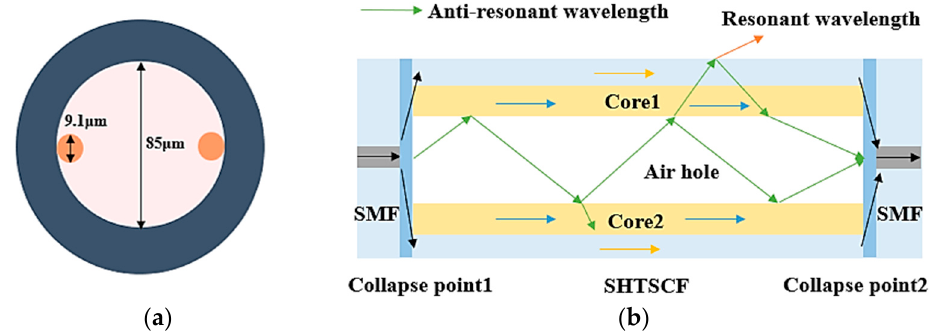
Figure 2. ( a ) The aperture size of the SHTSCF; ( b ) Guiding mechanism of the SHTSCF.